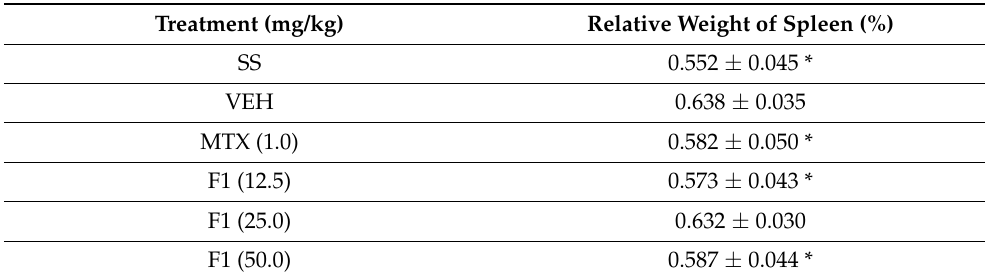
Figure 2. Effect of the F1 fraction of A. angustifolia extract at different doses on thermal hyperalgesia in inflamed joint in a murine K/C-induced mono-arthritis model. Data are reported as the mean ± SD for each group ( n = 12) and were analyzed by ANOVA with post hoc Bonferroni test. * p ≤ 0.05 with respect to the vehicle-treated group (Tween-20, VEH). SS: saline solution; MTX: methotrexate. Table 3. Effect of the F1 fraction of A. angustifolia extract on spleen index (percentage of total body weight).